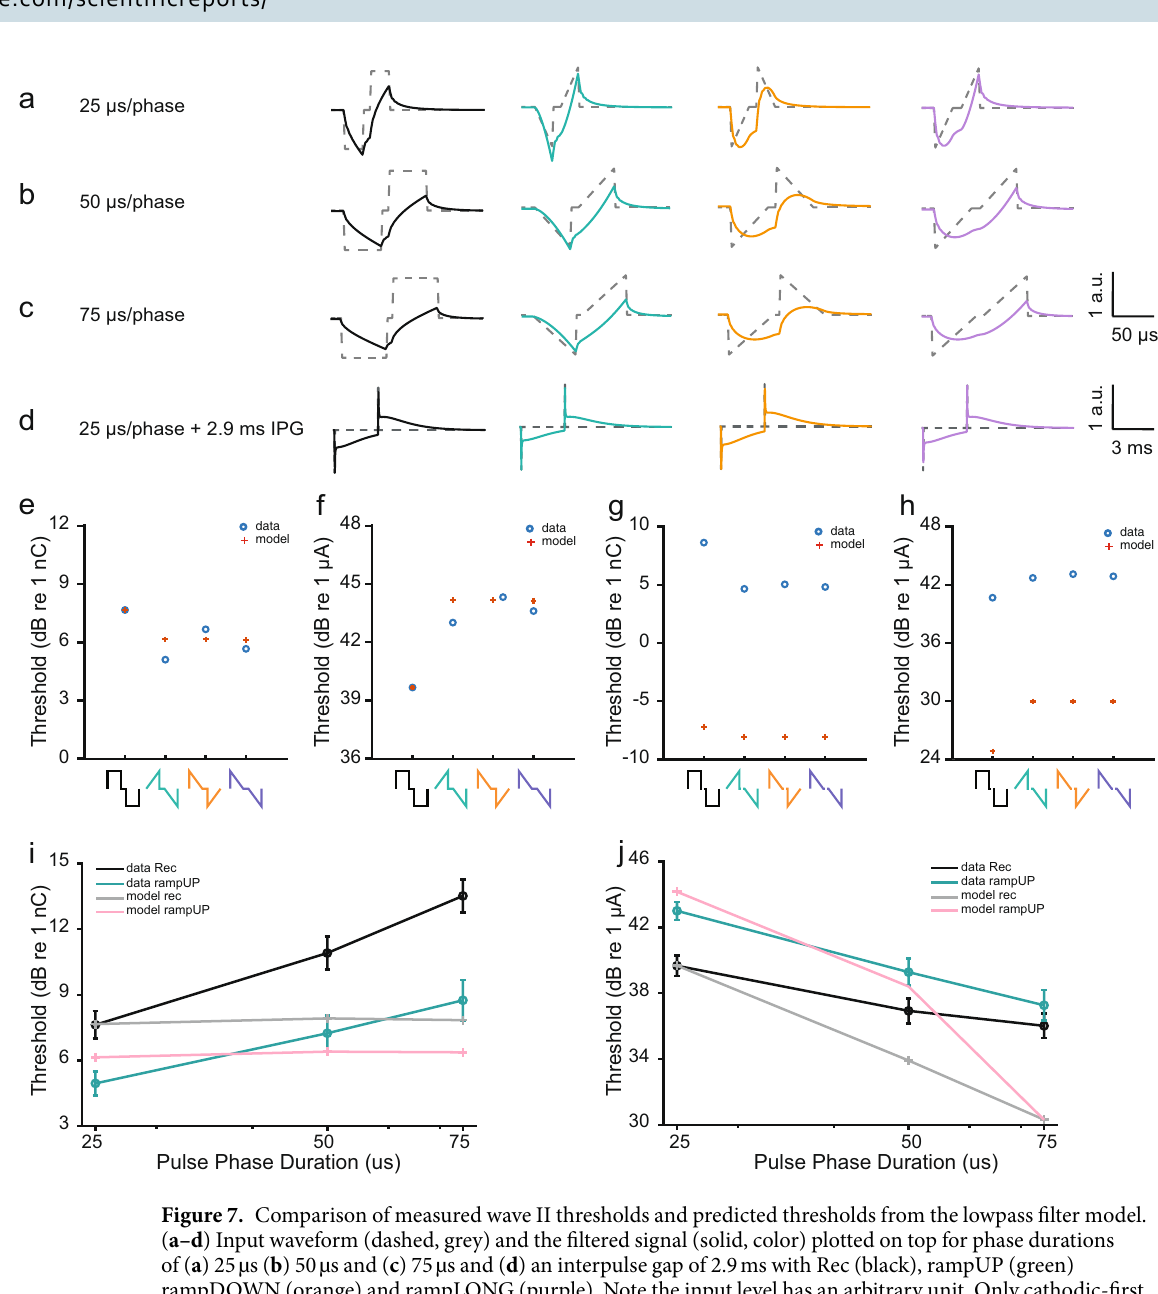
perfused through the round window. Next, a small piece of spongostan soaked in neomycin was placed within the round window niche and an acoustic ABR was recorded 45 minutes afterwards. A 4-channel electrode array (platinum bands of Ø0.2 mm, spaced at 0.4 mm interval, Bionics Institute, Melbourne, Australia) was inserted into the scala tympani until the 4 th platinum ring was located just inside the round window. This gave an insertion depth of ~2 mm, corresponding to an intracochlear position at ~30 kHz 53 . The lead wire was then coiled inside the bulla and the incision was closed. A silver wire ground ball was placed in a subcutaneous pocket in the neck.